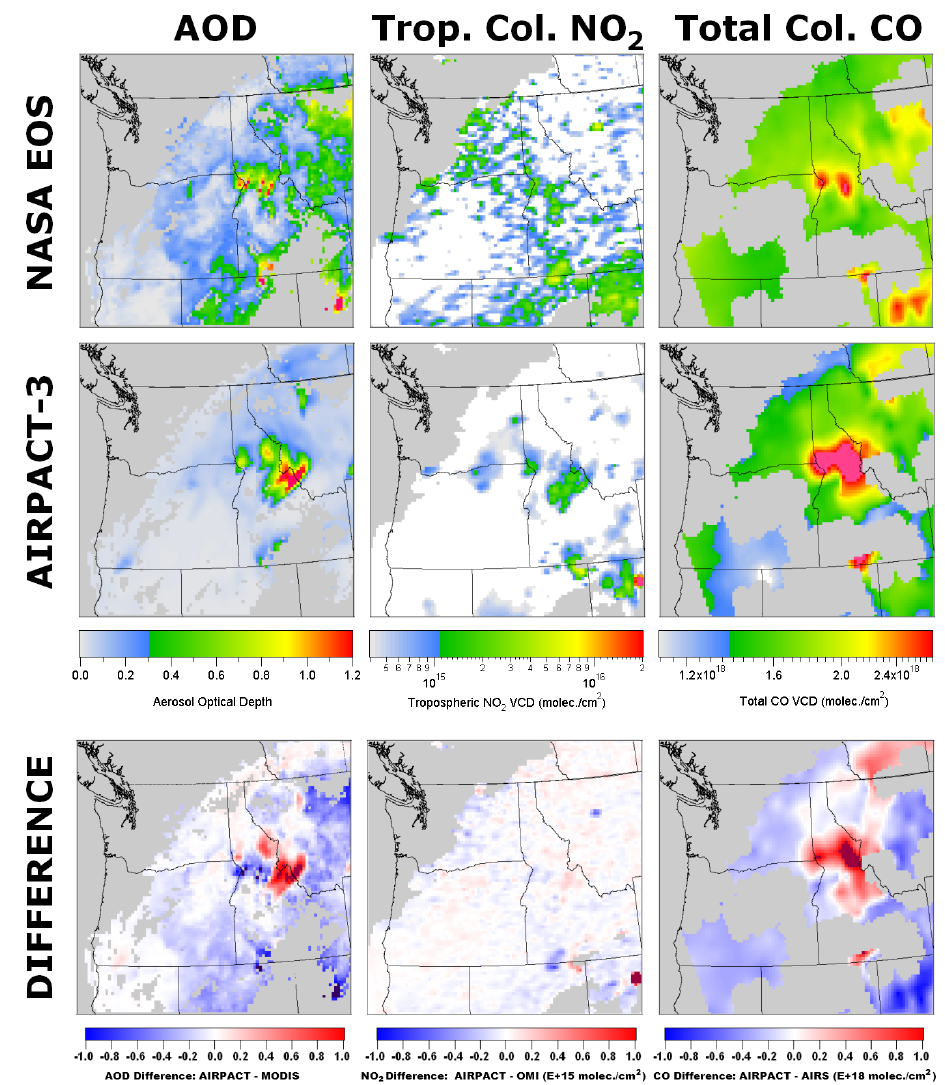
Figure 3. AOD (left column), tropospheric NO 2 columns (middle column), and total carbon monoxide columns (right column) for 22 July 2007 ( ∼ 2p.m.LST) with NASA EOS retrieval (top row), AIRPACT-3 with SMOKE plume rise (middle row), and differences (bottom row). Gray color indicates no or low-quality data from the satellite retrieval and exclusion from analysis. Values greater than the color scale maximum are shown as pink in the AIRPACT-3 and NASA EOS maps. Values outside the range of the difference color scales are shown as saturated